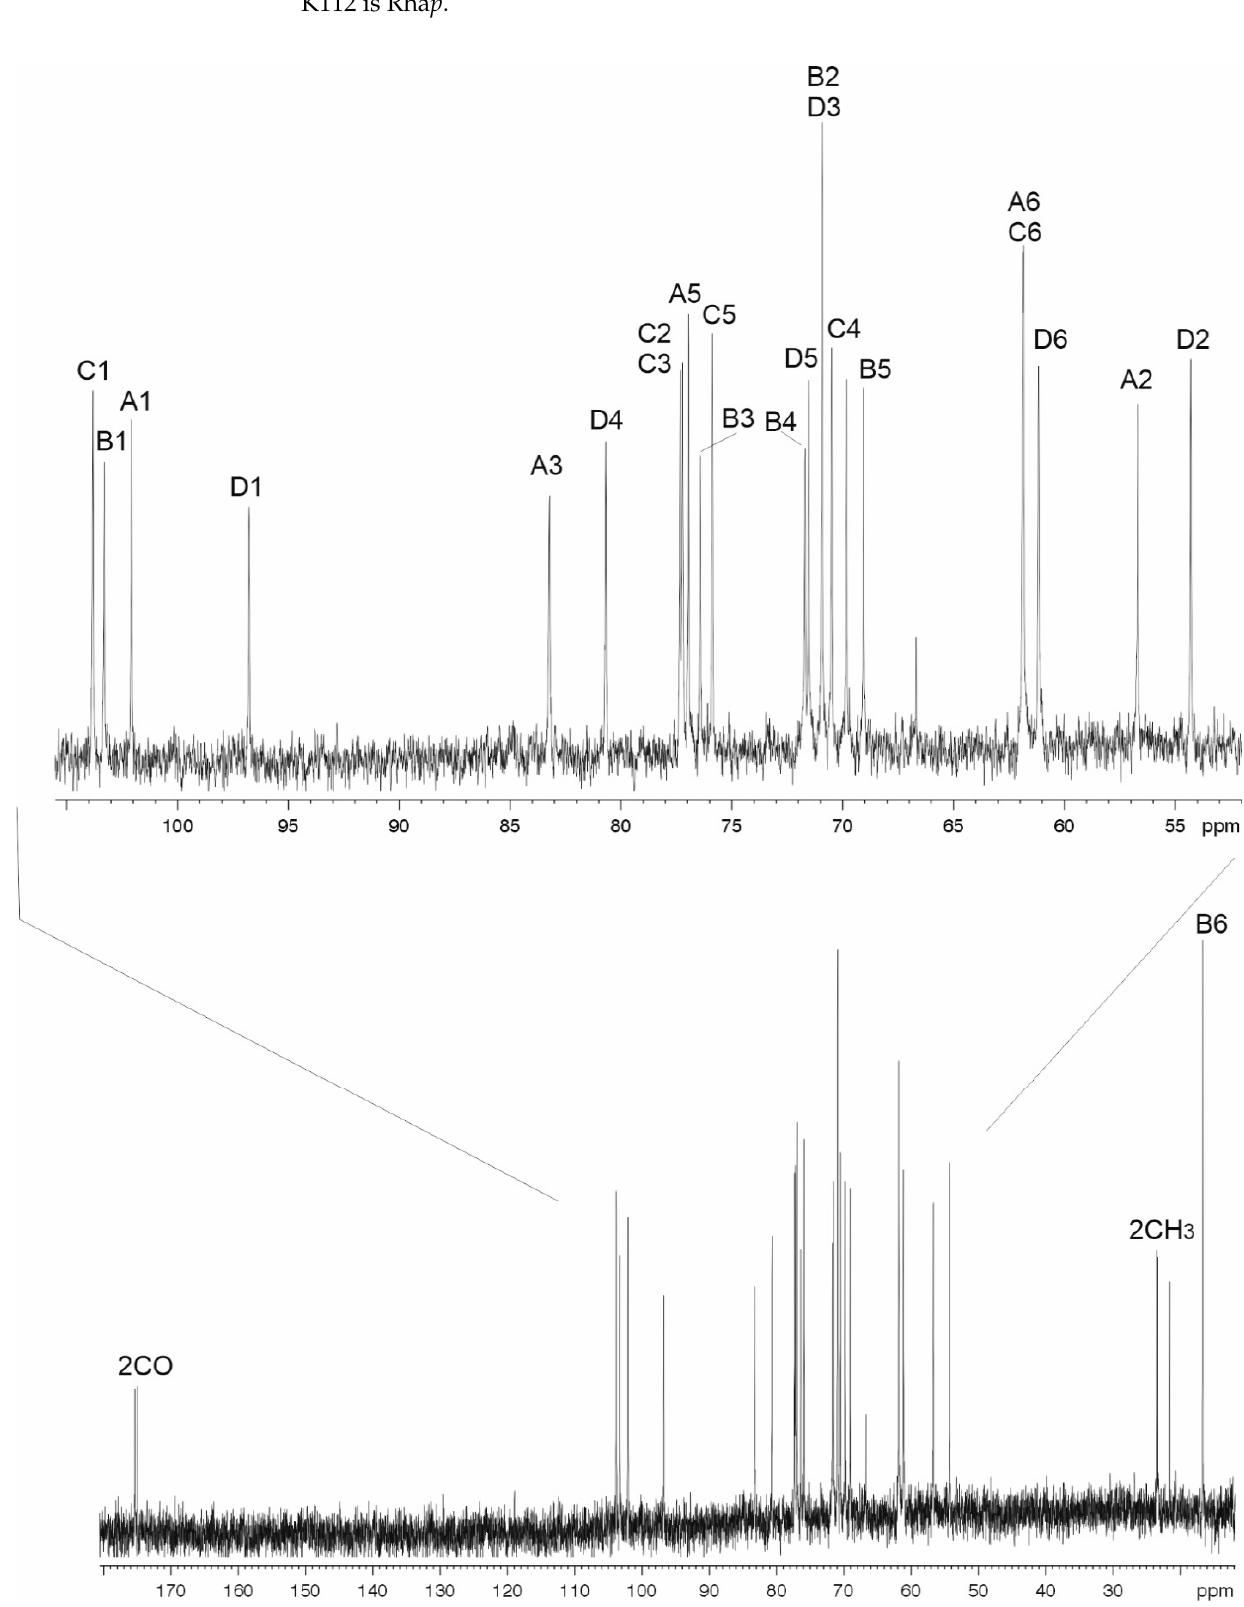
(Table 2). All monosaccharides were in the pyranose form. Hence, the additional sugar in K112 is Rha p .